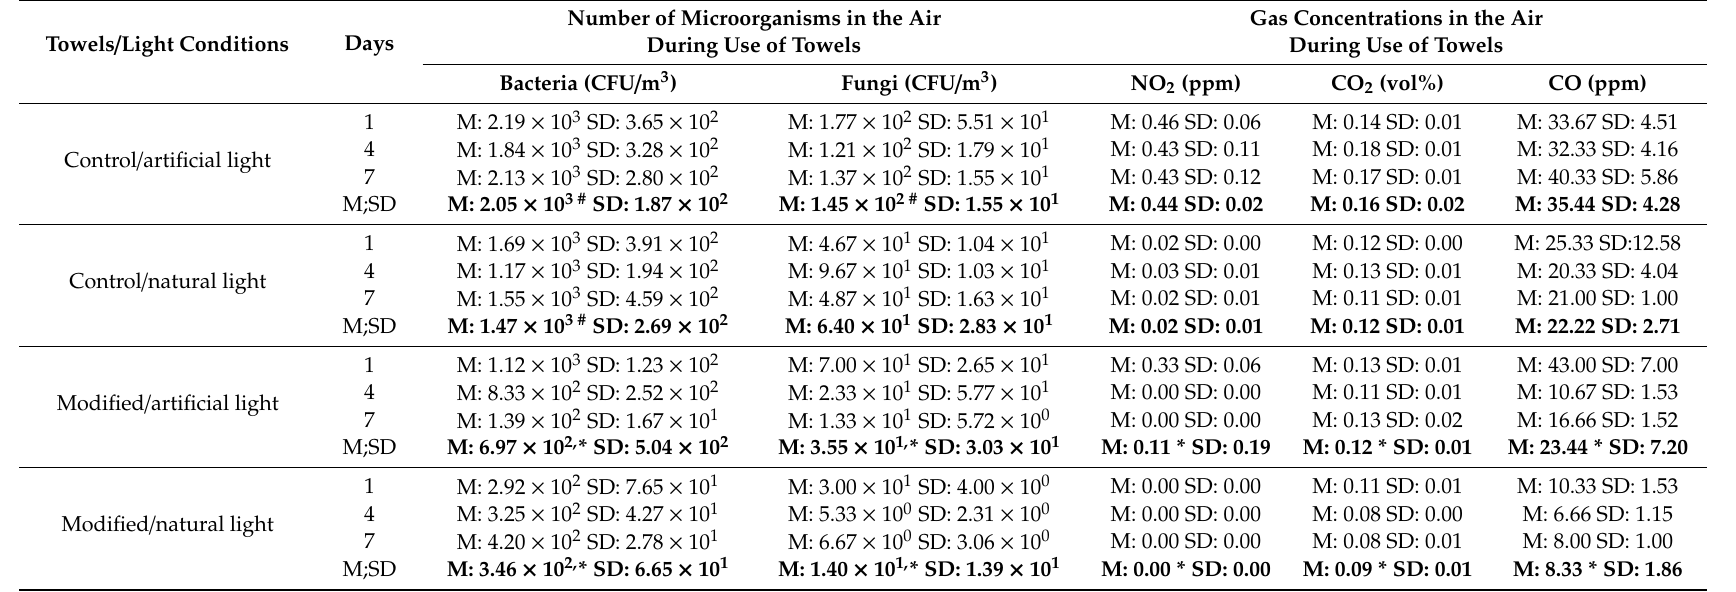
Table 5. Microbial contamination of air and gas concentration in the air during seven days of towel use in di ff erent light conditions. Number of Microorganisms in the Air Towels / Light Conditions Days During Use of Towels